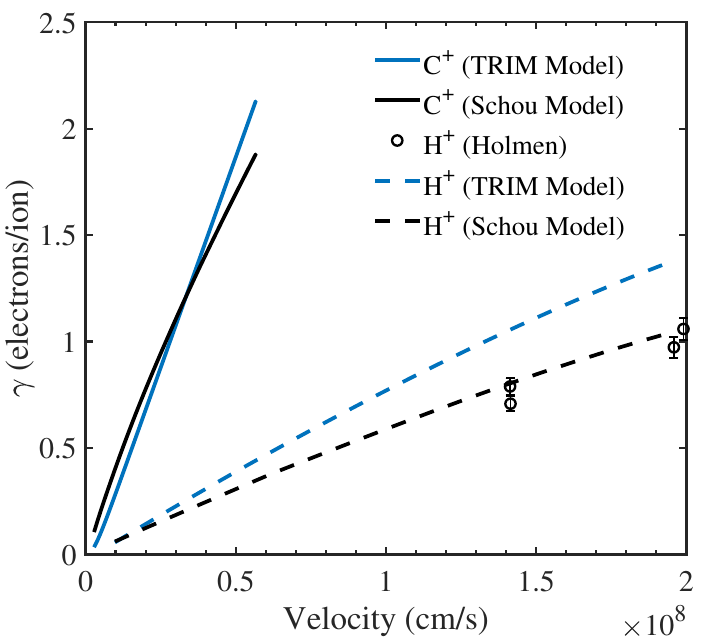
Figure 6. Average electron yield as a function of velocity for both carbon and hydrogen ions hitting copper from 0–20 keV for the TRIM and Schou models. Dashed lines represent proton impacts, while solid lines represent carbon ion impacts. Colors indicate the model utilized. Data taken from Holmén et al. (Holmen)